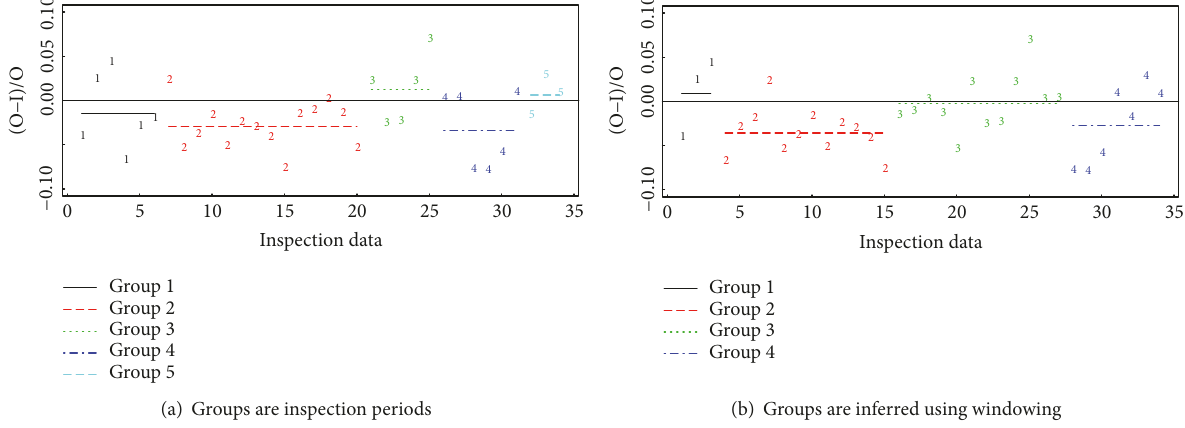
Figure 8: Real (O-I)/O data with the groups being the inspection periods in (a) and the groups being inferred using windowing in